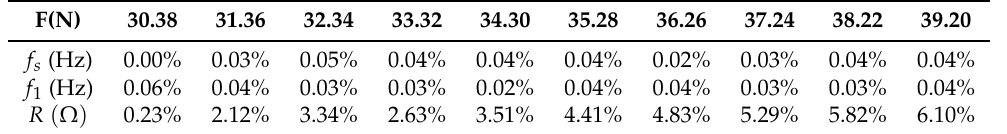
Table 8. 30–40 N error